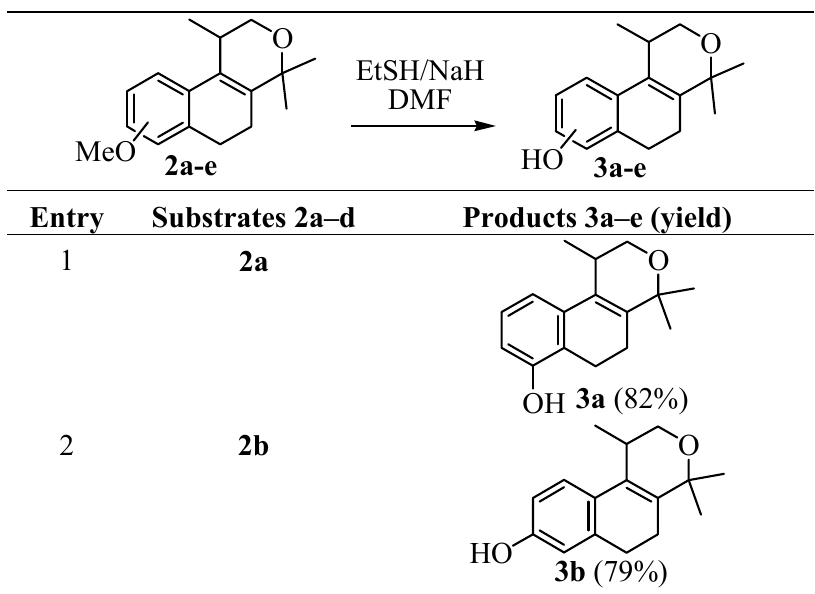
Table 2. Cleavage of the ether